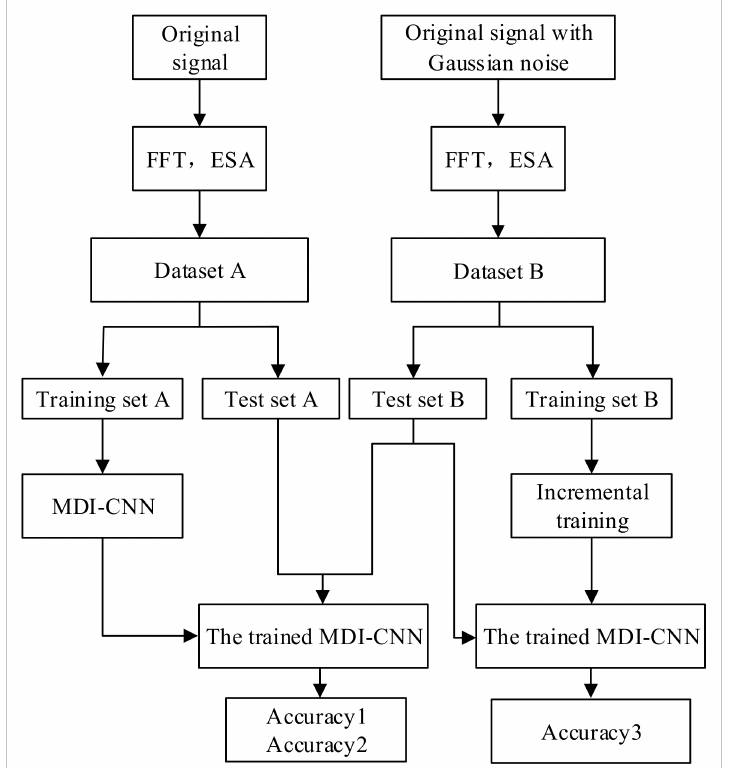
Figure 2. The flowchart of the validation method for the MDI-CNN model. Accuracy 1 and Accuracy 2 represent the classification accuracy obtained by entering normal test samples and test sample containing the noise into the trained MDI-CNN, respectively, and Accuracy 3 indicates the classification accuracy of the model after the incremental training on the noisy test samples. MDI-CNN, Multi-Dimension Input convolutional neural network; FFT, Fourier transformation; ESA, envelope spectrum